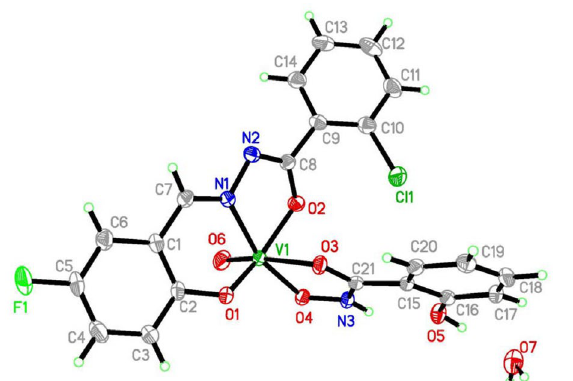
Figure 2. Molecular packing diagram of 1 . Viewed along the a axis. Hydrogen atoms not related to hydrogen bonding are omitted. Hy- drogen bonds are shown as dashed lines.